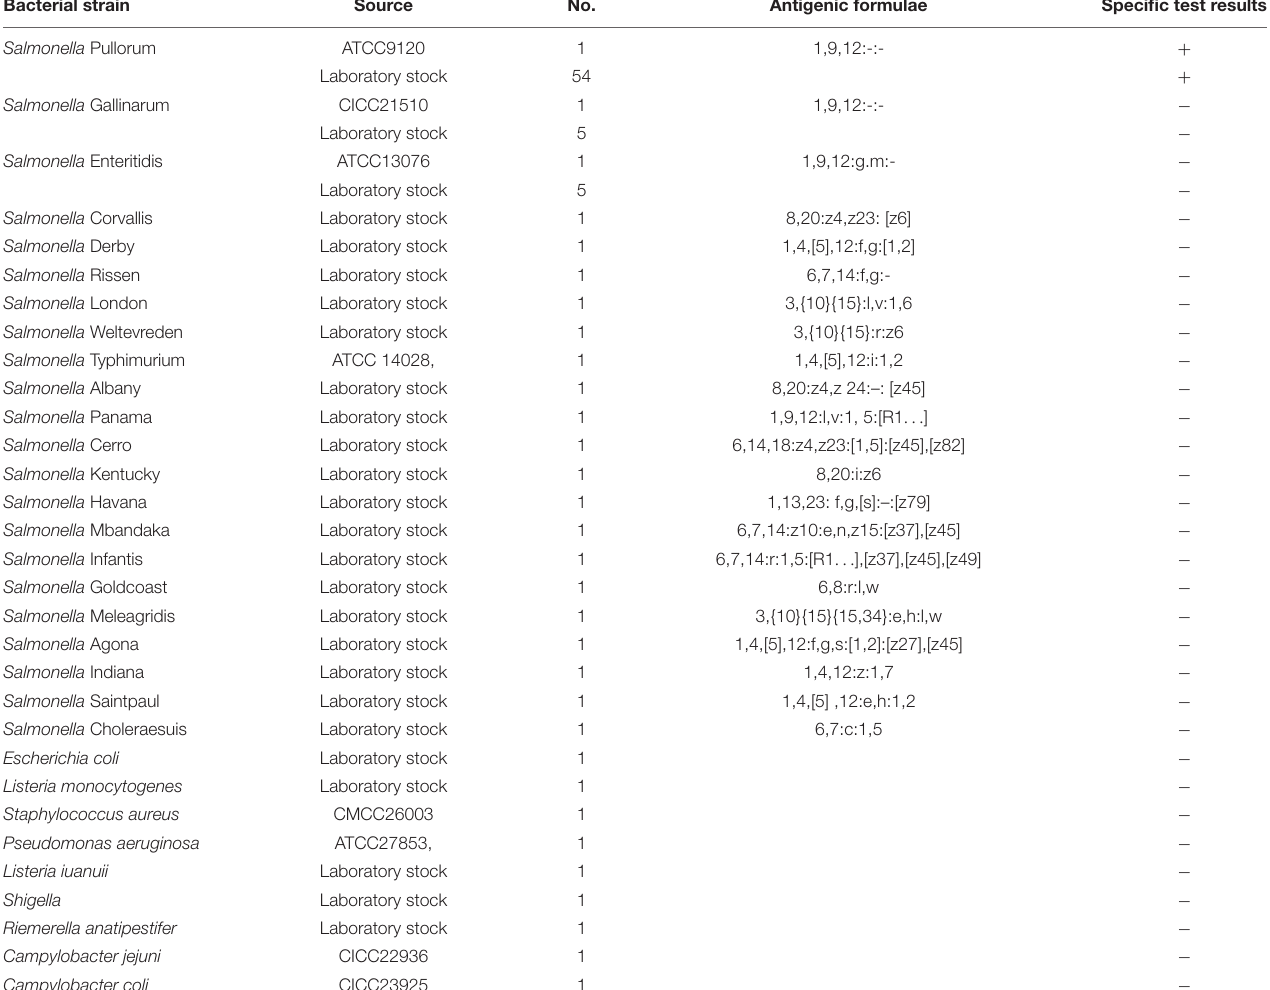
TABLE 1 | Salmonella and non- Salmonella strains used in this study and specificity test results. Bacterial strain Source No. Antigenic